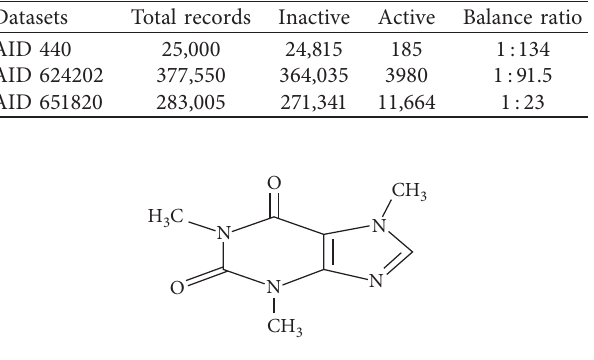
Figure 3: Molecules (chemical compound)